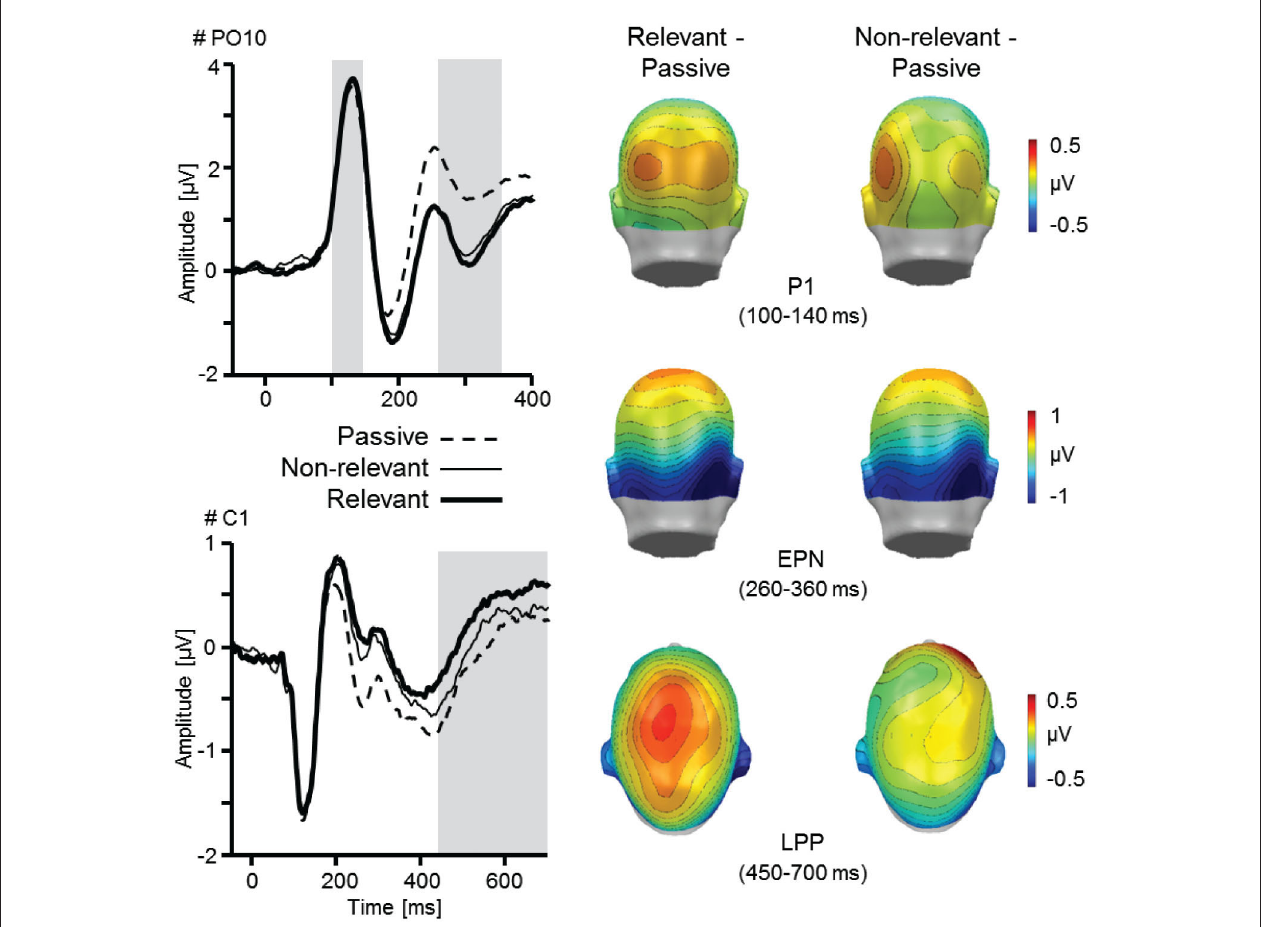
Topographical difference maps (relevant–passive, non-relevant–passive) display the averaged time interval plotted on the back of a model head (P1: 100–140 ms; EPN: 260–360 ms) and a top view (LPP: 450–700 ms). Analyzed time windows are highlighted in gray (PO10: P1 and EPN; C1: